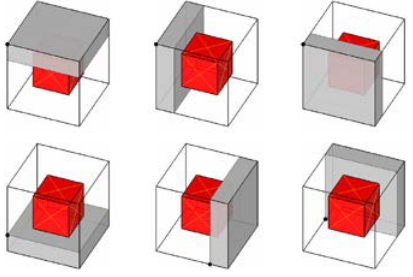
Fig. 1. New potential containers in a three-dimensional case .